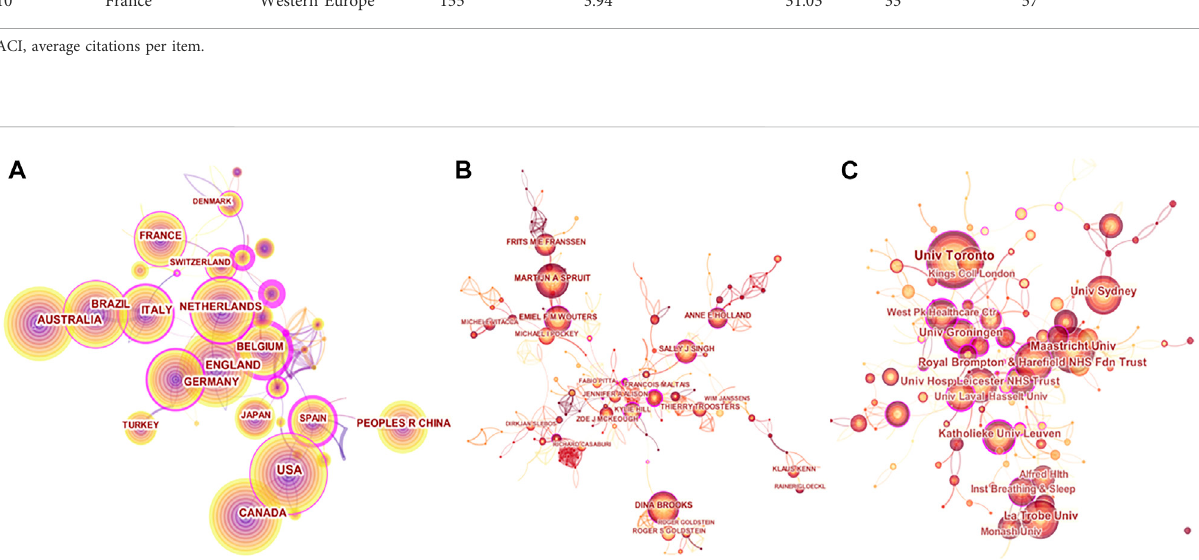
multidimensional rotation, and panoramic mapping in map